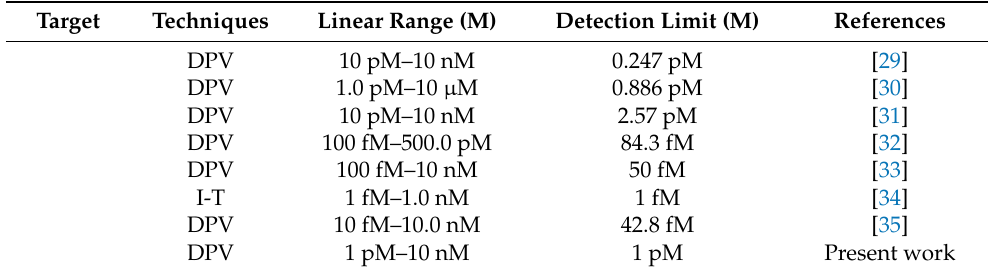
Table 2. Comparison of LODs.